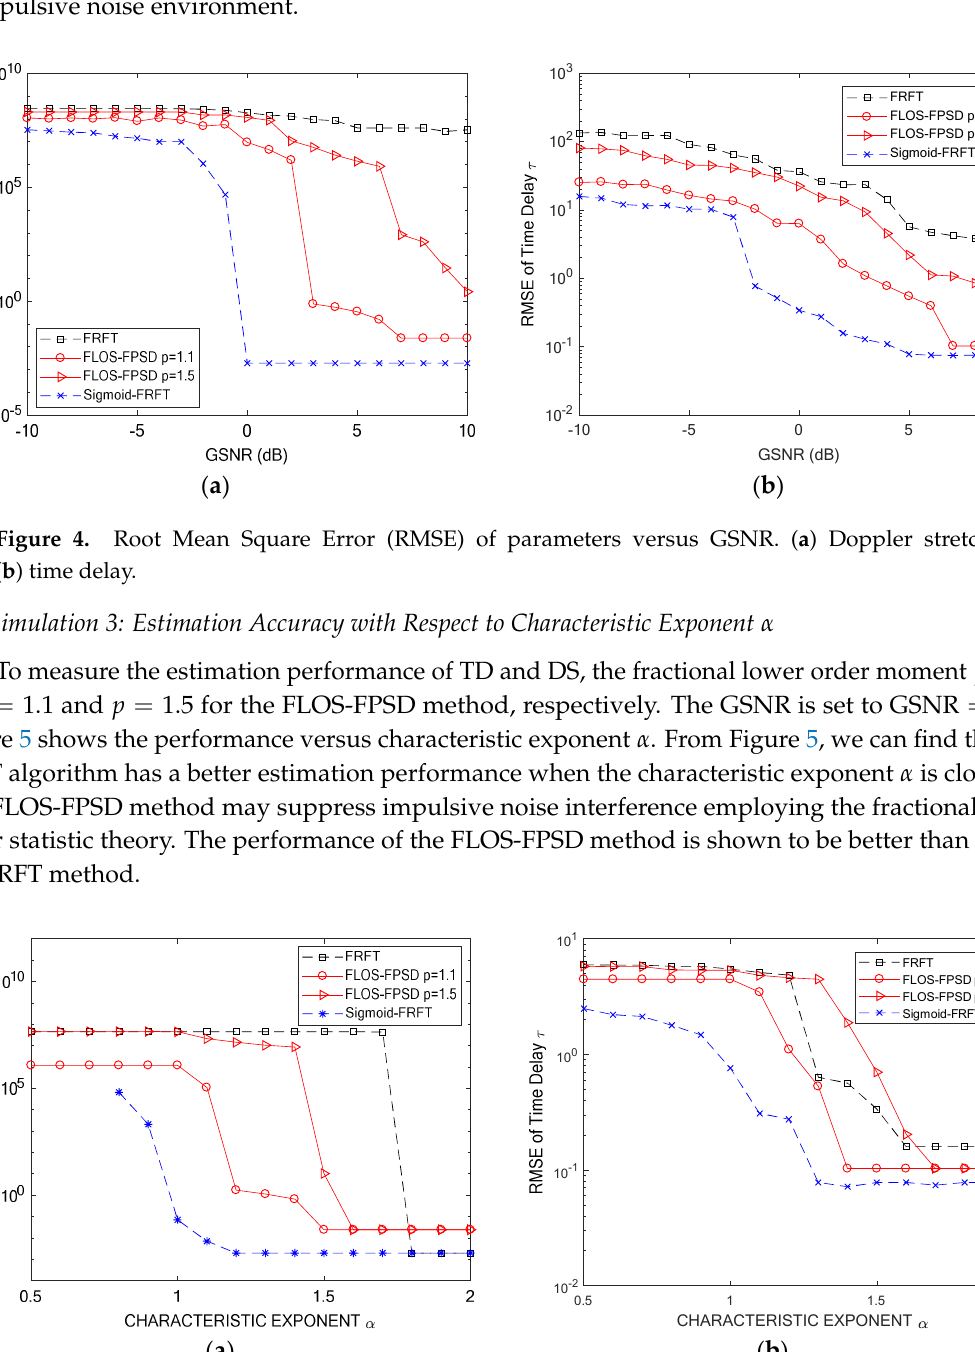
Figure 5. RMSE of parameters versus Characteristic Exponent  . ( a ) RMSE of Doppler stretch; ( b ) RMSE of time delay.